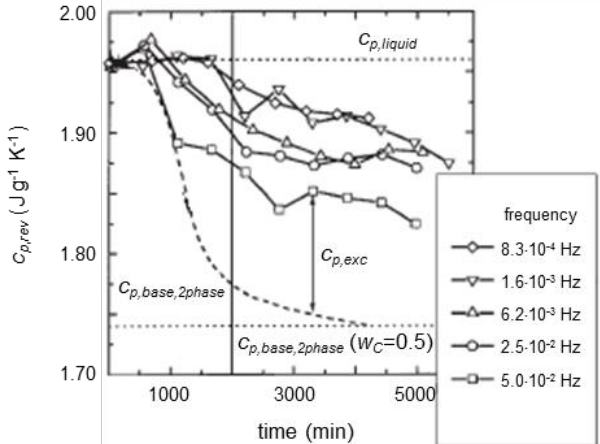
Figure 8. Reversing-specific heat capacity ( c p,rev ) during crystallization of PCL at 55 °C as a function of crystallization time ( A T = 0.5 K). c p,base,2phase was calculated according to Equation (3). (Reprinted (adapted) with permission from [7]. Copyright (2000) Springer).